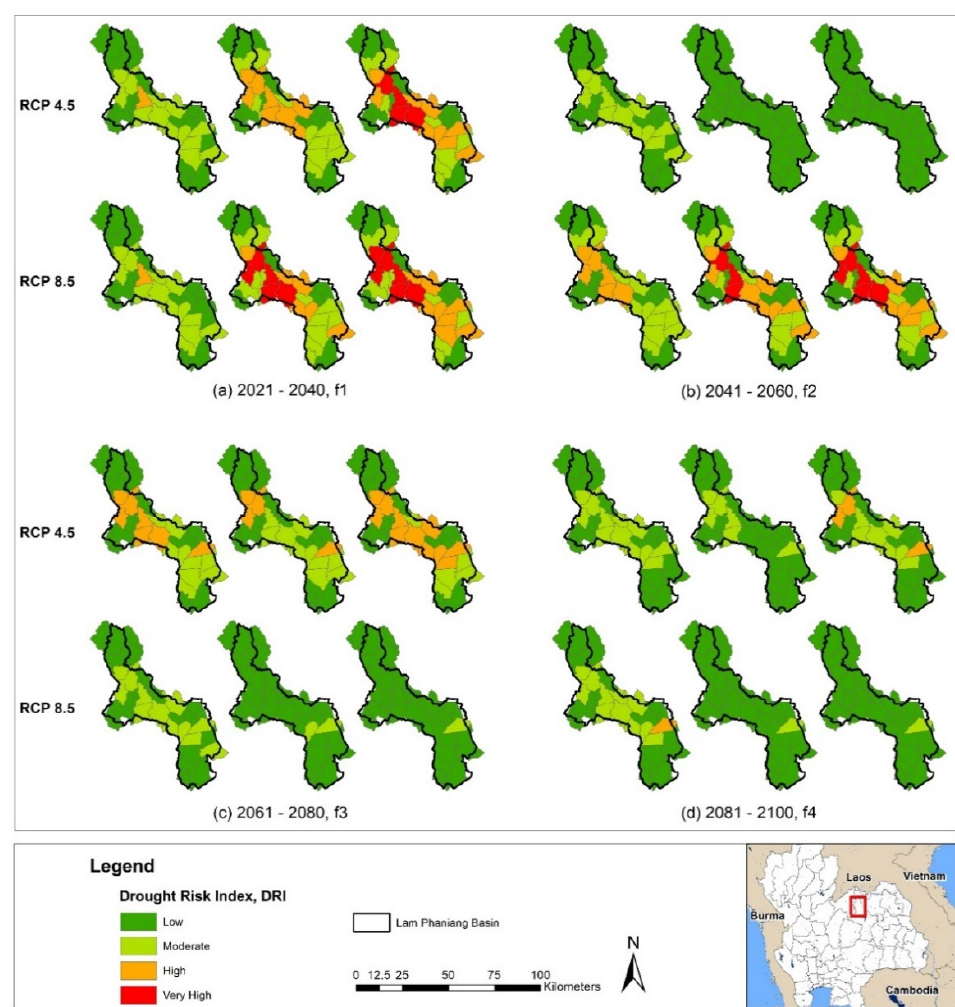
Figure 8. Spatial drought risk maps of the Lam Phaniang River Basin at 3-, 12-, and 24-month time scales under RCPs 4.5 and 8.5 during ( a ) 2021–2040, ( b ) 2041–2060, ( c ) 2061–2080, and ( d ) 2081–2100.